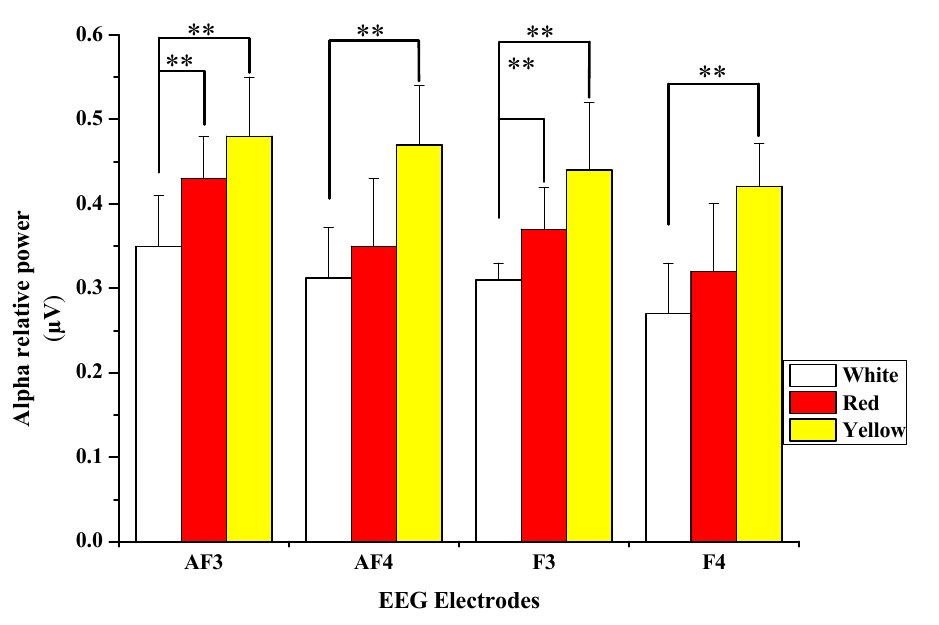
Figure 4. Alpha relative power variability in AF3, AF4, F3, and F4 electrodes while viewing white, red, and yellow flowers. ** p < 0.01 is defined by Bonferroni correction.